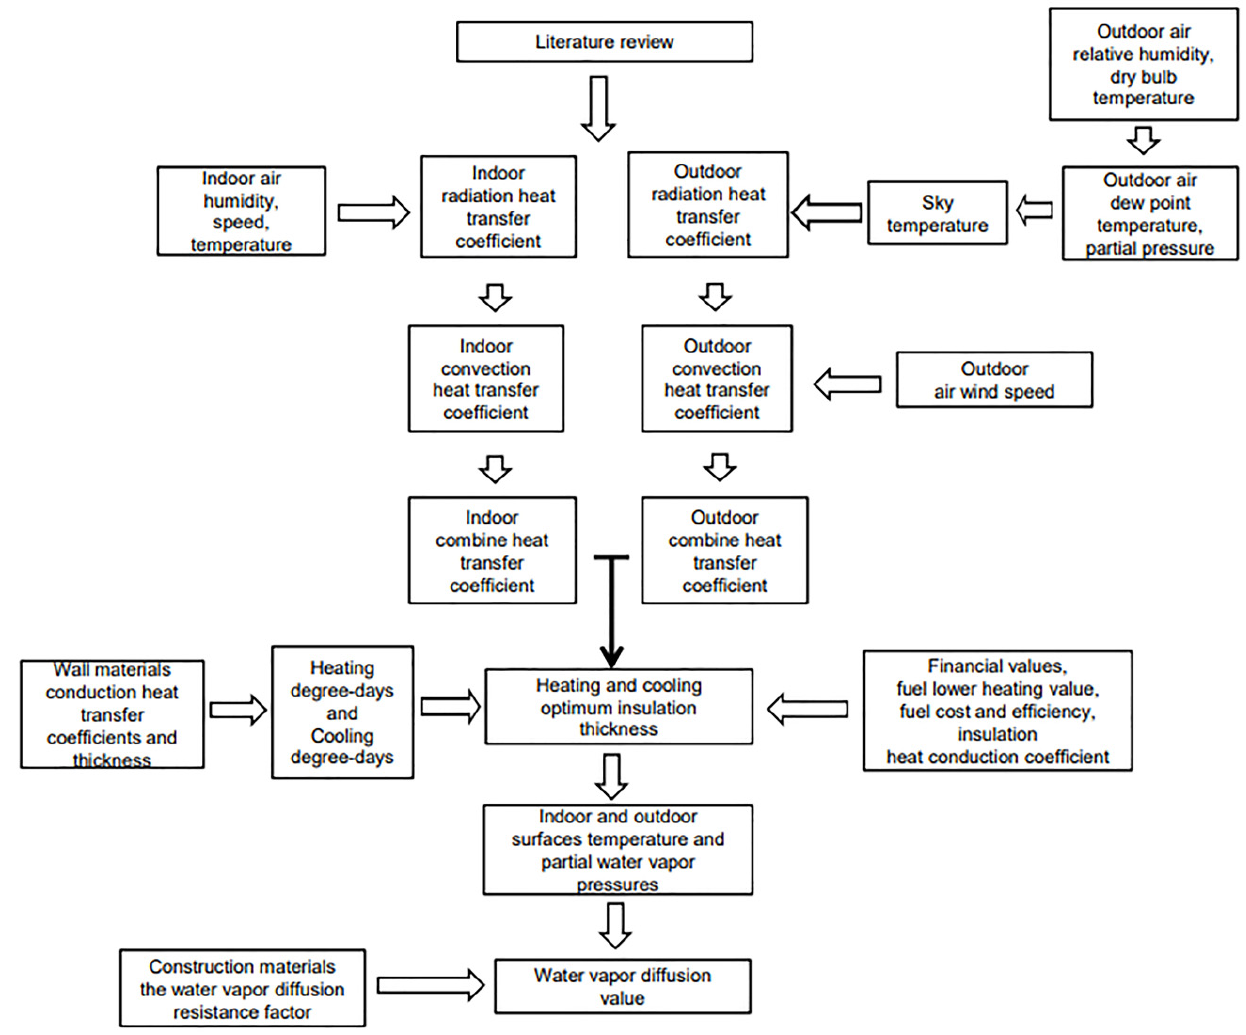
Figure 4. Study conceptual framework of the study. In the calculations, firstly, indoor and outdoor convection and radiation heat transfer coefficients were calculated for the cities representing each climate zone, depending on the different meteorological parameters of each city. Thus, the overall heat transfer coefficients were determined for the indoor and outdoor environments. The optimum insulation thicknesses were calculated depending on the conduction heat transfer coefficient, financial values, fuel, and cost of insulation materials based on the heating and cooling degree-days for each city. With this insulation thickness, the necessary relative humidity values were found for the formation of mold and moisture on the inner surface of the wall. During the calculations, uninsulated and insulated walls were taken into account depending on dew point temperatures. The temperature value and partial water vapor pressure values in each layer formed with different wall properties were calculated. By determining the wall and insulation materials water vapor diffusion resistance factor, the water vapor diffusion values that will occur on the wall have been